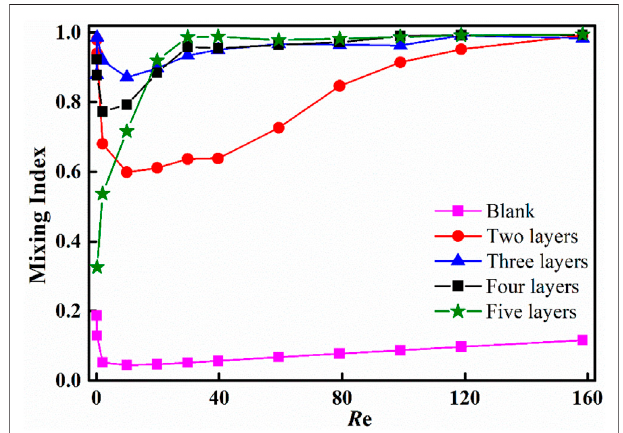
FIGURE 4 | Mixing index at the outlet of the microreactor with different numberoflayers(standardinserts, s / l (cid:1) 2, V / H (cid:1) 10:10, l (cid:1) 1 mm, V (cid:1) 10 mm).